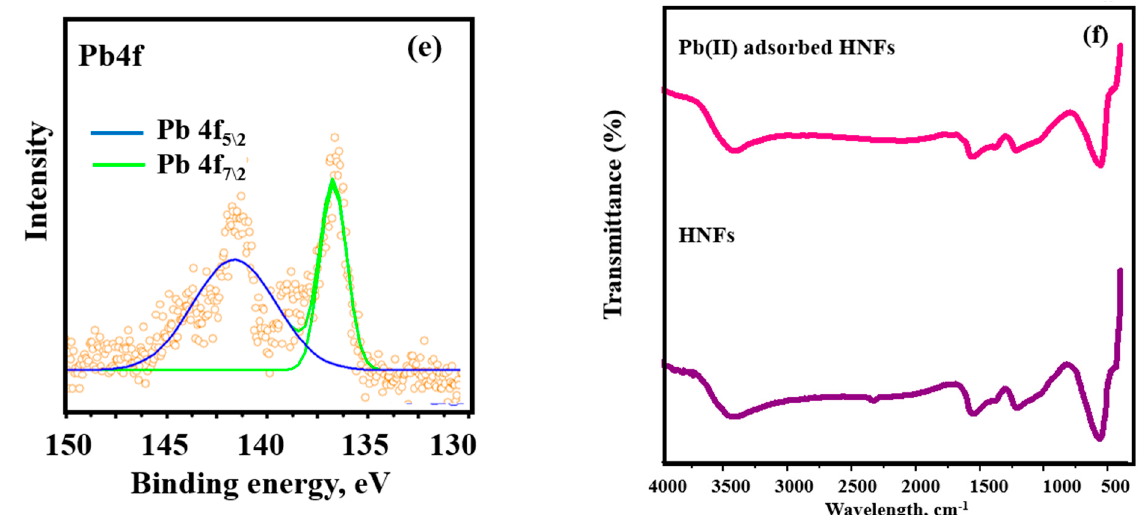
Figure 8. ( a ) The influence of contact time ( b ) kinetic plot (Experimental conditions: optimum pH, malathion concentration—2.0 mg L − 1 , HNFs dose—0.2 g L − 1 ), ( c ) Kinetic studies of inhibition of degradation of malathion, ( d ) Full survey spectrum of HNFs and Pb(II)-adsorbed HNFs, ( e ) XPS high resolution spectra of Pb ’ 4f’and ( f ) FT − IR spectra of HNFs and Pb(II)-adsorbed HNFs. In (a,b) straight lines represents fitting of model, where C and C t represents concentration of malathion at initial time “t” and at time “t”, respectively